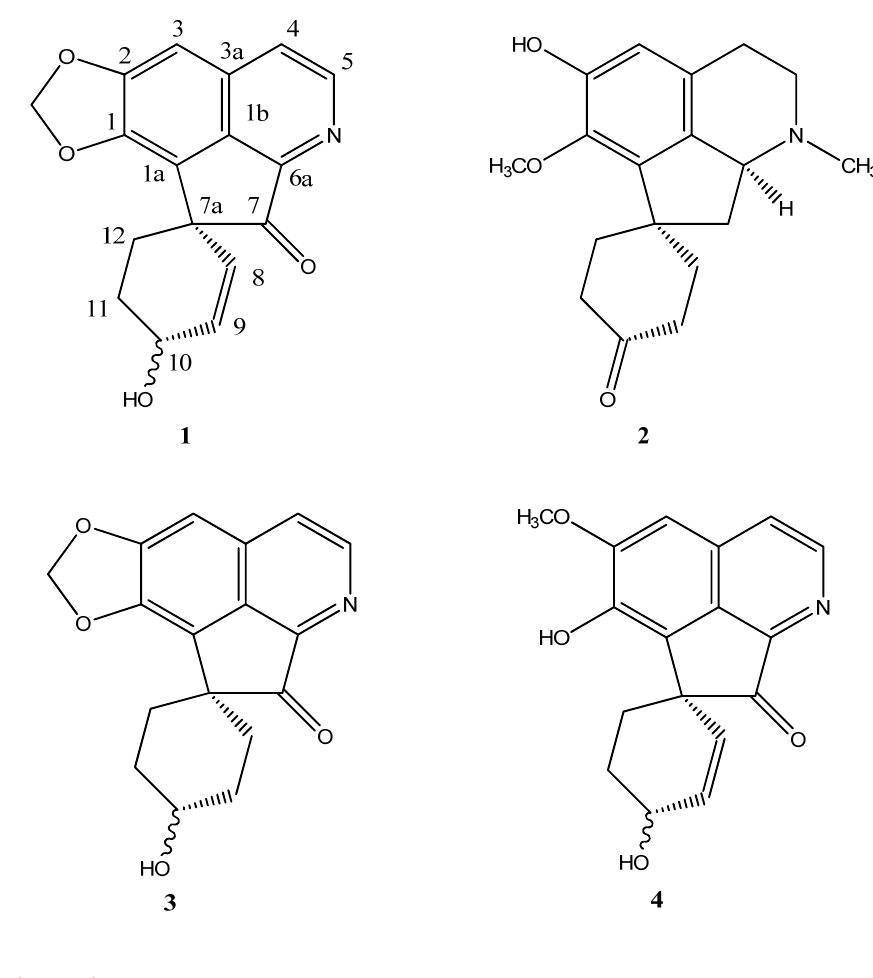
Figure 1. Structures of (+) –grandine A 1 , (-)-8,9-dihydrolinearisine 2 , (+)-scortechiniine B 3 and prooxocryptochine